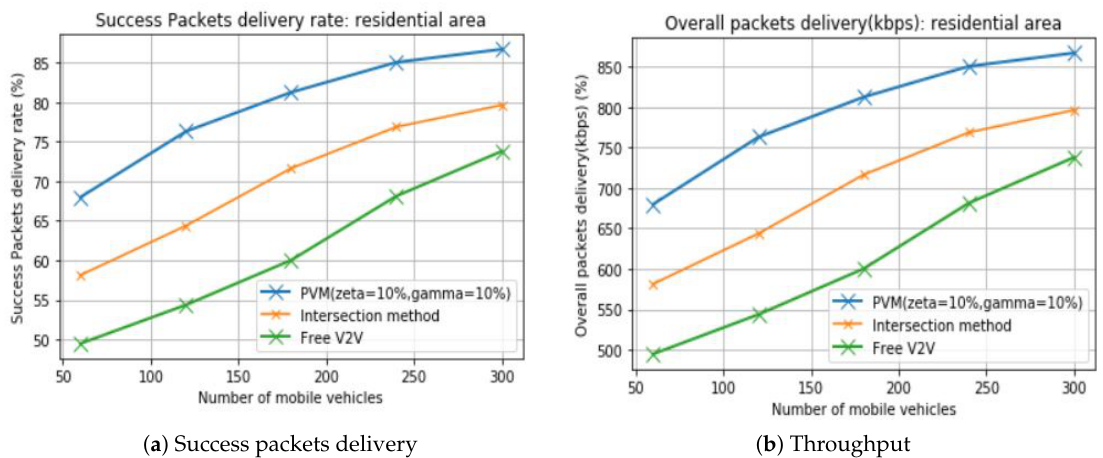
Figure 25. Success Packets delivery & Throughput: Residential